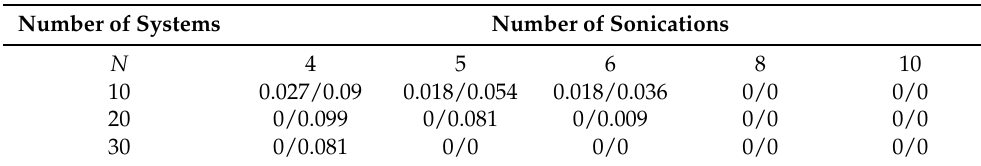
Table 3. Median percentage of non-treated/mistreated area from 15 independent runs as a function of the number of systems N and the number of sonications.